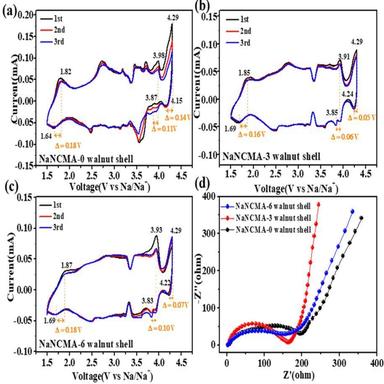
CV curves at a scan rate of 0.1 mV s1 for (a) the walnut-shell-like NaNCMA-0, (b) NaNCMA-3 and (c) NaNCMA-6 samples. (d) Nyquist plots of the walnut-shell-like NaNCMA-0, NaNCMA-3 and NaNCMA-6 samples.